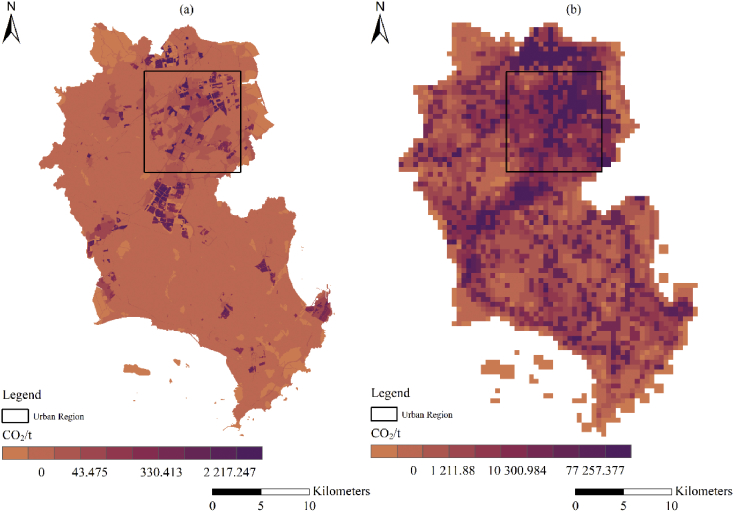
The high-resolution CO2 girded maps. (a) and (b) represent the CO2 emissions gridded maps at R30m and R500m respectively.